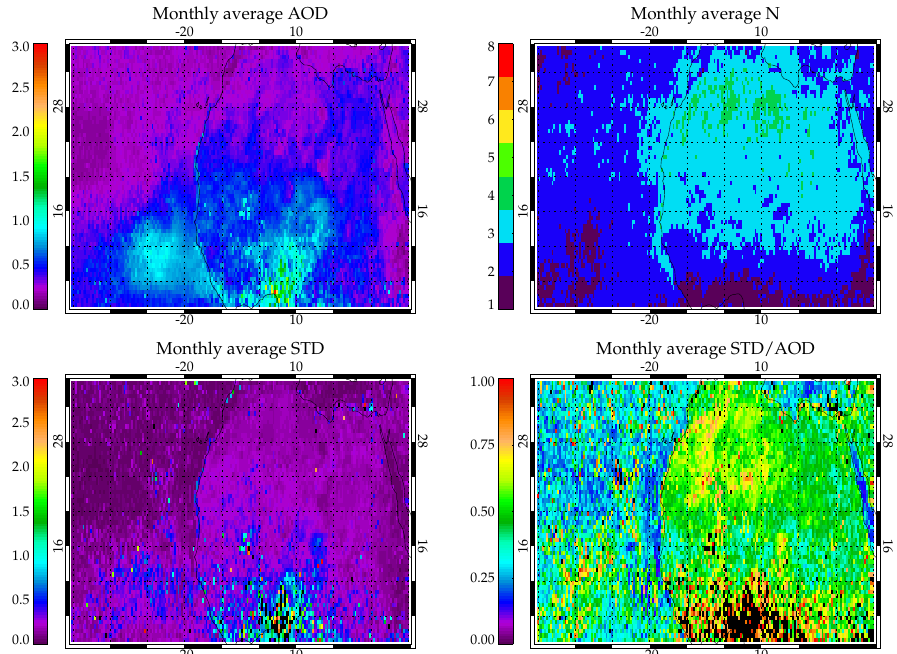
Fig. 14. Monthly average of AOD (top left), number N of instruments considered (top right), standard deviation (bottom left) and ratio between standard deviation over AOD (bottom right). Values in black are higher than the maximum of the colourbar.